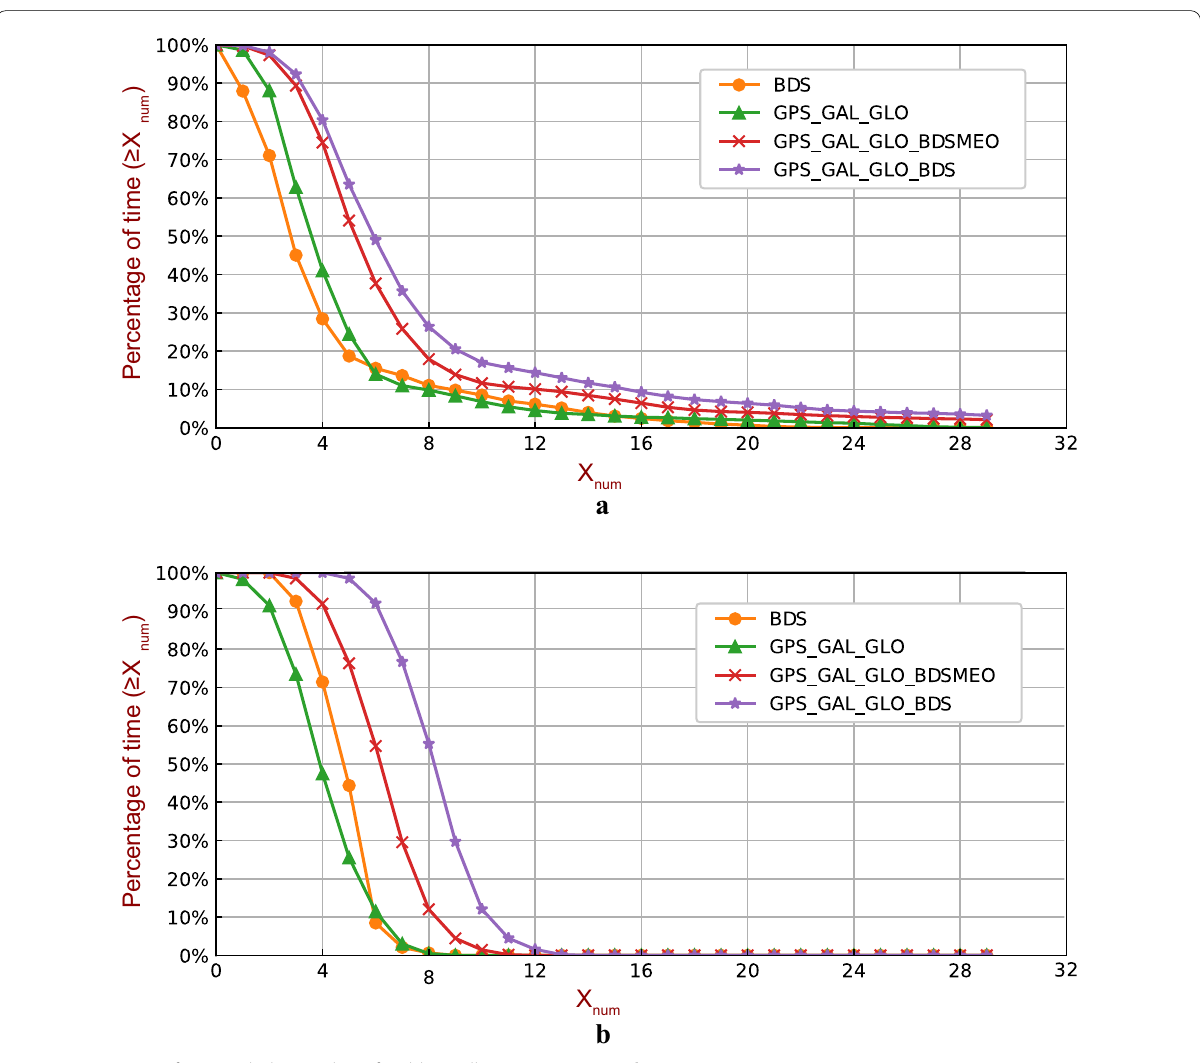
Fig. 7 Percentage of time with the number of visible satellites